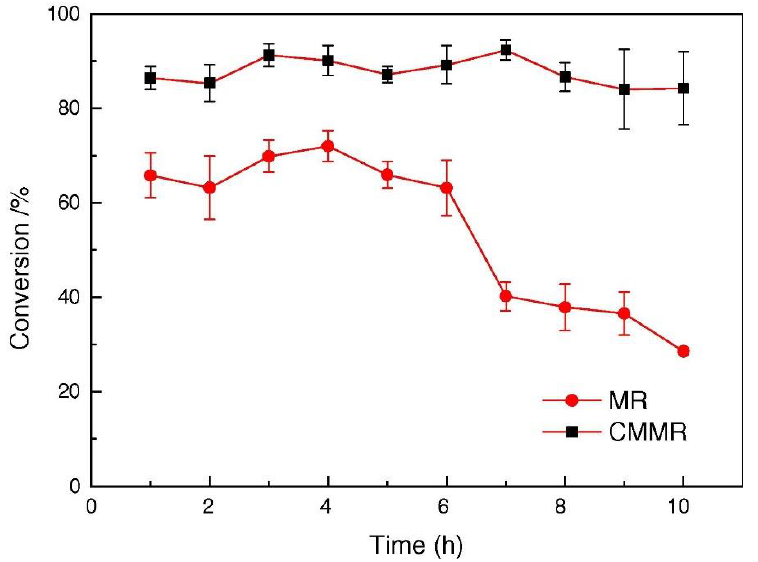
Figure 8. Comparison between catalytic membrane reactor (CMR) and packed bed membrane reactor (PBMR) [102].